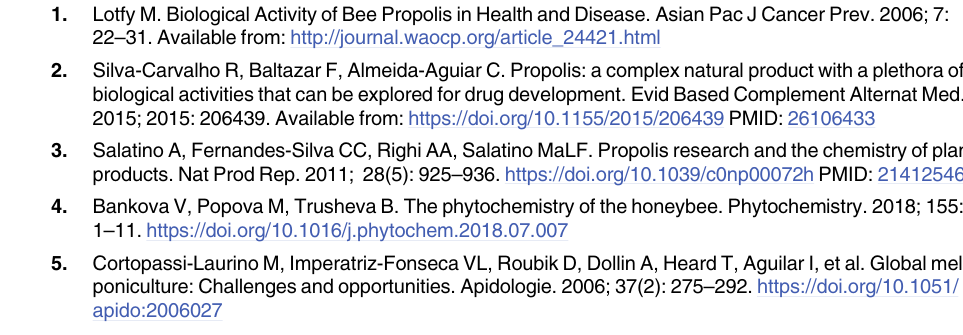
S7 Fig. 1 H, 13 C, HSQC and HMBC NMR spectra of compound 7 in CDCl (PDF) S8 Fig. 1 H NMR spectrum of compound 8 in CD (PDF) S9 Fig. 1 H NMR spectrum of compound 9 in CD (PDF) S10 Fig. 1 H NMR spectrum of compound 10 in CDCl (PDF) S11 Fig. 1 H NMR spectrum of compound 11 in CDCl (PDF) S12 Fig. 1 H NMR spectrum of a mixture 12 in CDCl